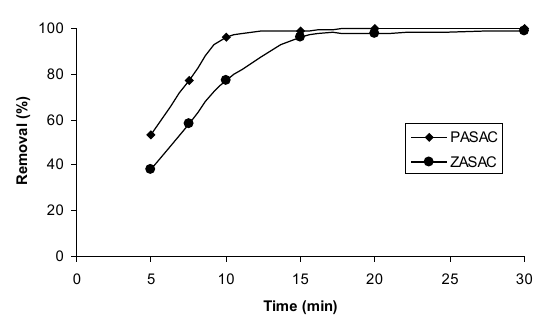
Figure 5. The effect of contact time on adsorption Pb(II) onto (a) PASAC and (b) ZASAC. Conditions were the same as Fig. 4, except to agitation